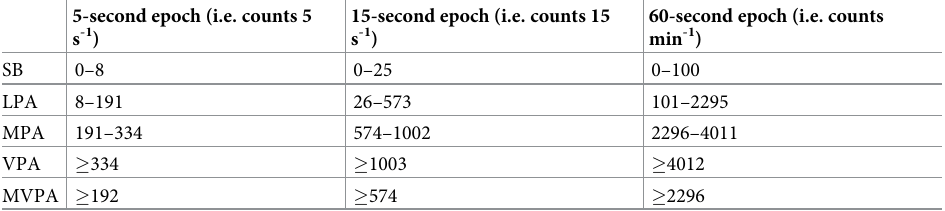
Table 1. Evenson cut-points for sedentary behaviour and physical activity adjusted to match epochs of 5, 15 and 60 seconds. 5-second epoch (i.e. counts 5 s -1